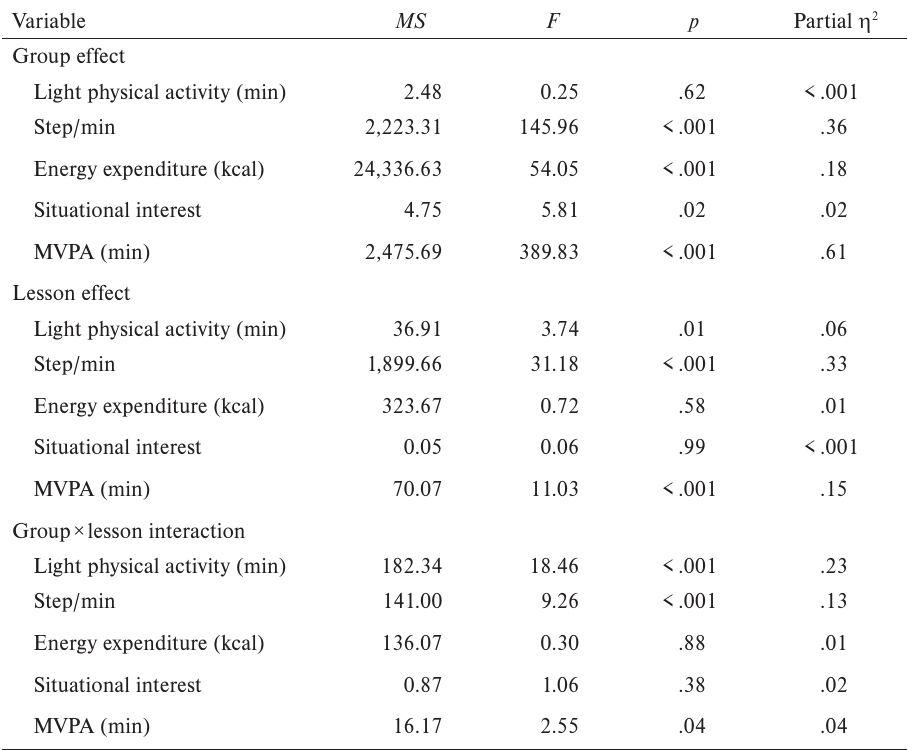
Table 5 Test of group, lesson, and group × lesson effects on physical activity and